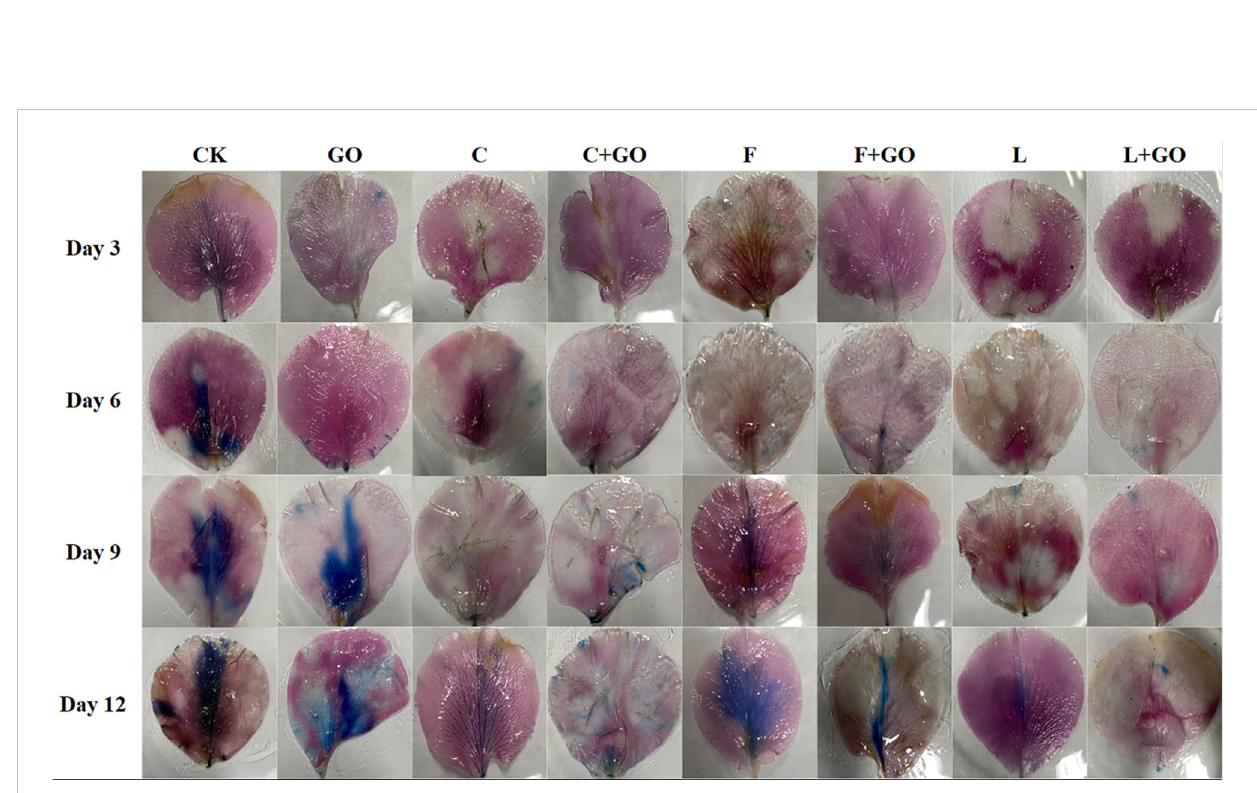
FIGURE 7 Evans Blue staining of the petals of the cut rose fl owers after 12 d of treatment. Scale bar: 1 cm.